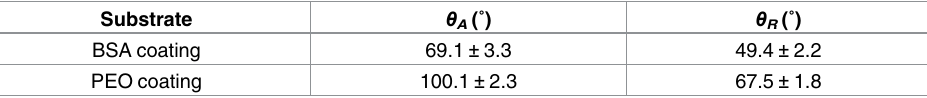
Table 2. Dynamic advancing and receding contact angles of water on a BSA-coated glass slide and a PEO-coated glass slide.